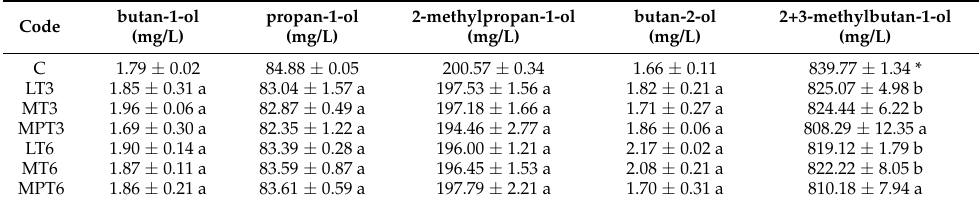
Table 3. Mean and Standard deviation of higher alcohol of the AUS aged with oak wood.